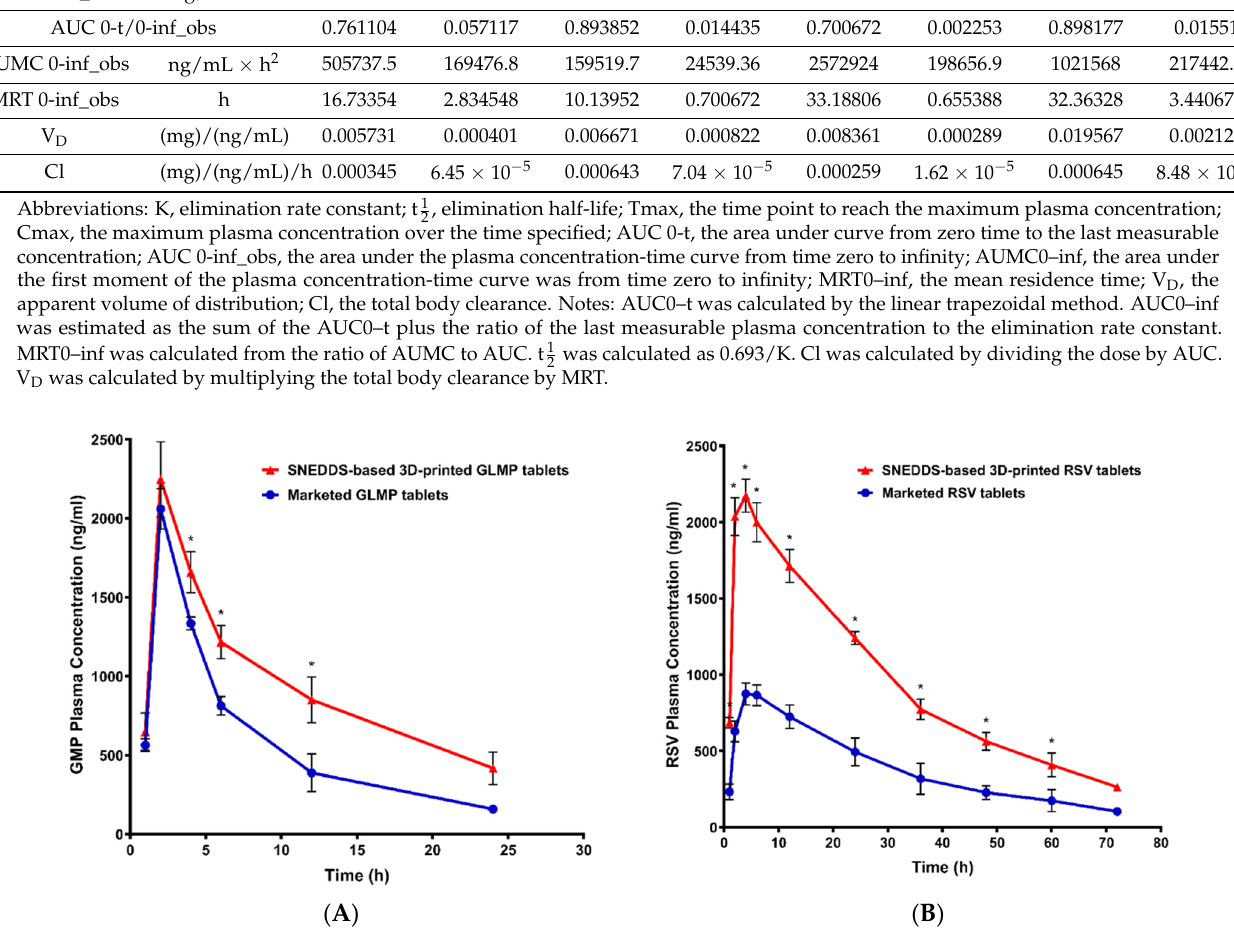
Figure 6. Plasma level-time curves for glimepiride ( A ) and rosuvastatin ( B ) after oral administration of the 3DP and marketed tablets to Male Wistar rats (n = 6). Note: * Indicates significant difference, at p < 0.05, between